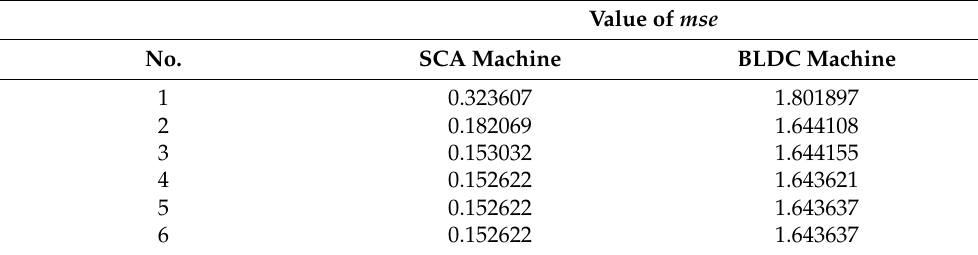
Table 3. Validation of the proposed method.